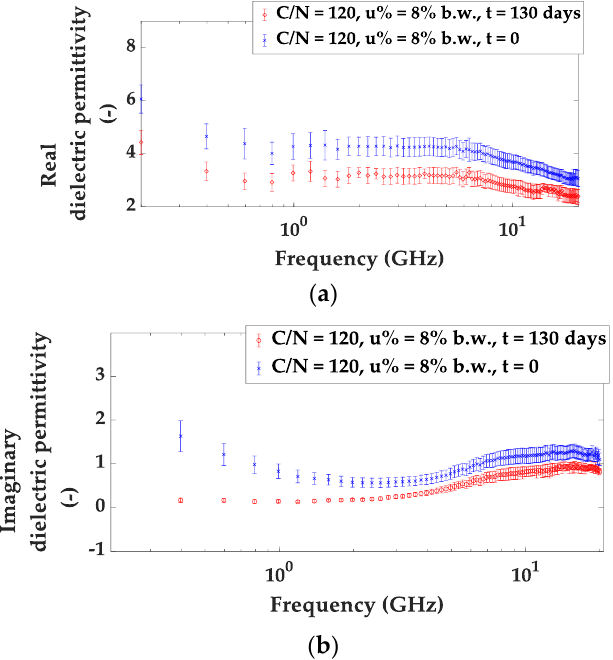
Figure 18. Dielectric permittivity of microcosms at t = 0 and t = 130 days: ( a ) real part; ( b ) imaginary part.